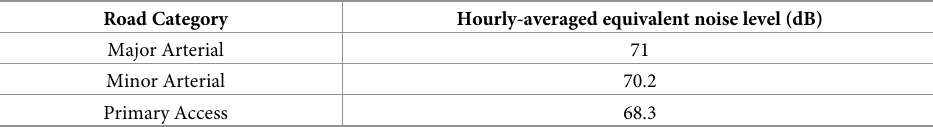
Table 2. Road categories used in this paper.